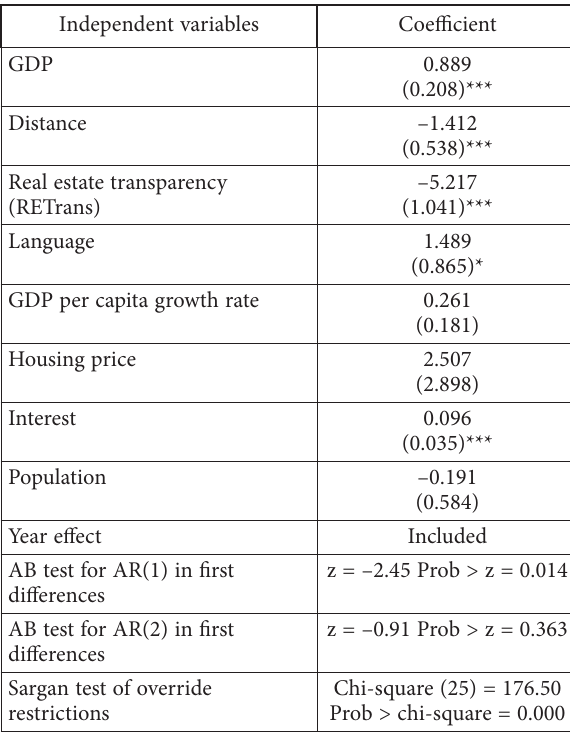
Table 4. Determinants of Chinese outward FDIRE: system GMM estimation